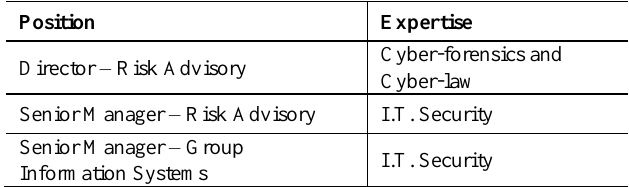
Table 1: Sample group 1 Position